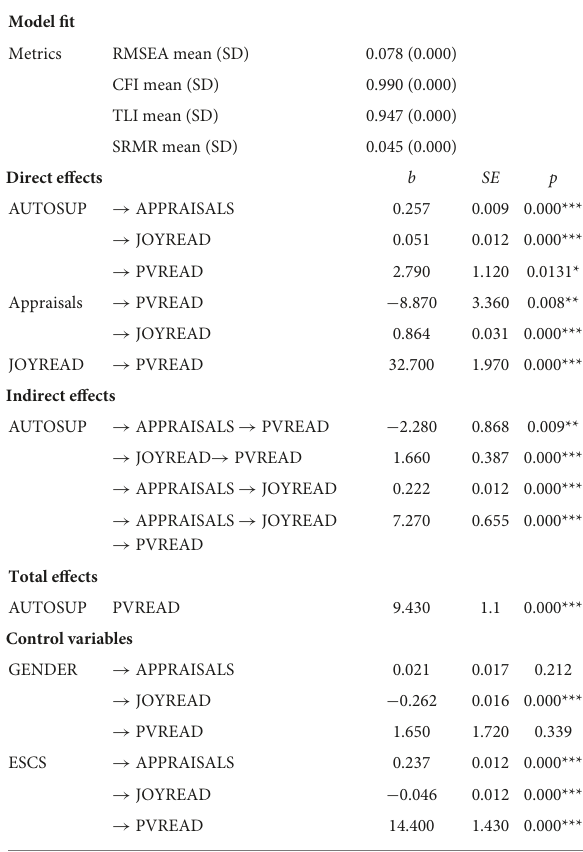
TABLE 2 Fit indices and the parameter estimates of the final